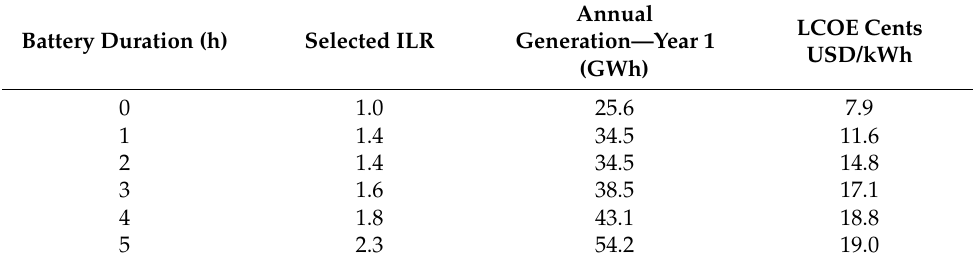
Table 5. Selected ILR as constrained by marginal clipping loss for fixed-tilt system.